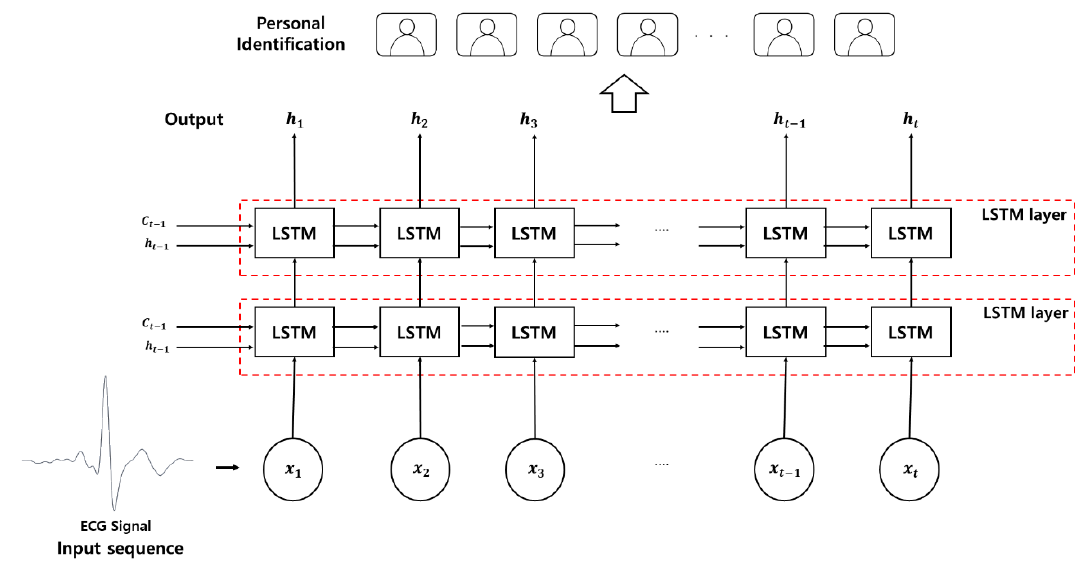
Figure 5. Two LSTM layers.